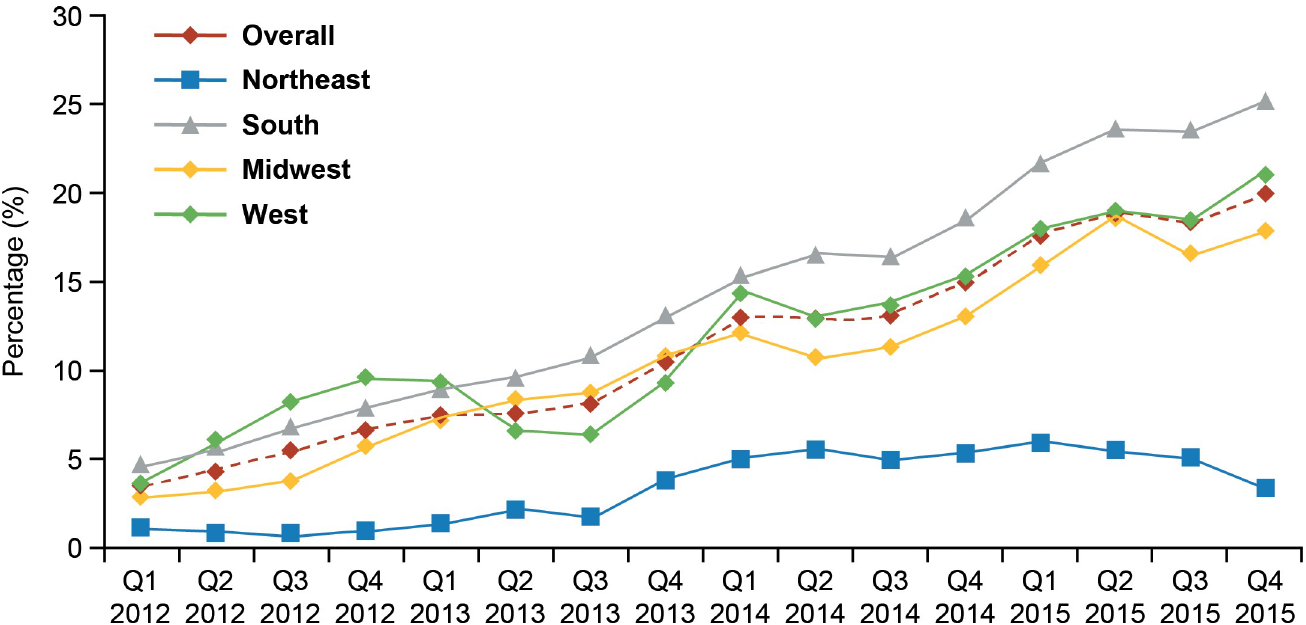
Fig 2. Quarterly proportion of sepsis discharges with � 1 PCT measurement by US Census region (y-axis maximum value = 30%). PCT, procalcitonin; Q, quarter.